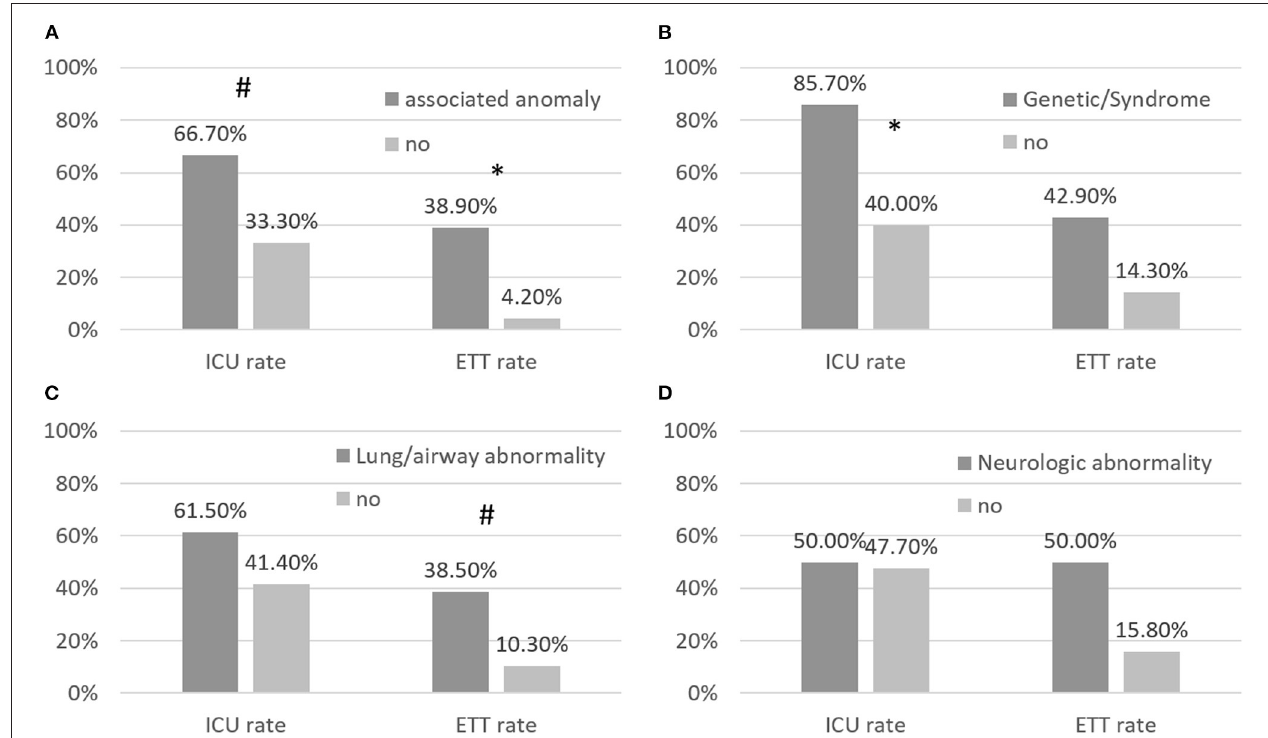
FIGURE 2 | (A–D) Rates of RSV-related admission to the intensive care unit (ICU) and rates of endotracheal intubation (ETT) in children with CHD and associated abnormalities. Patients with associated abnormalities had borderline higher RSV-related rates of ICU admission and ETT than patients with CHD without associated abnormalities. * annotates p < 0.05; # annotates p <